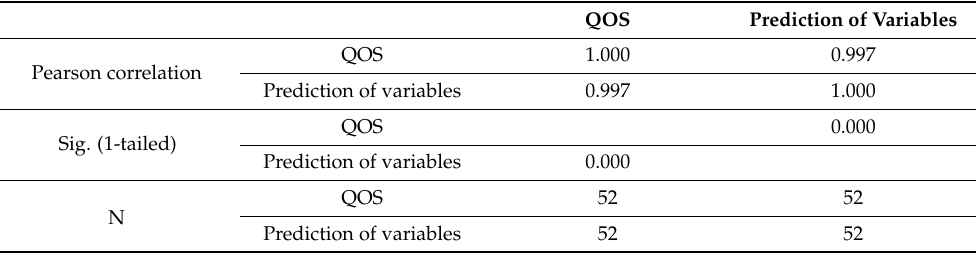
Table 9. Table of correlations among QOS and predictive values from linear regression